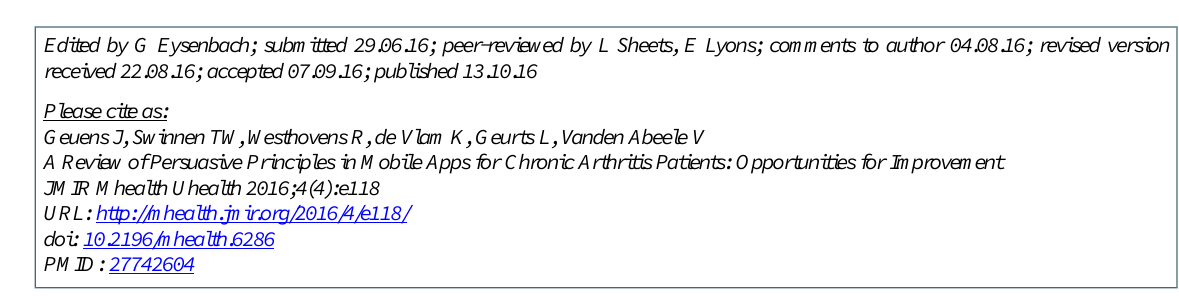
Fogg B, Hreha J. Behavior wizard: a method for matching target behaviors with solutions. In: PERSUASIVE 10.: Springer; 2010 Presented at: 5th International Conference on Persuasive Technology; June 7-10, 2010; Denmark p. 117-131 URL: http://link.springer.com/chapter/10.1007/978-3-642-13226-1_13 [doi: 10.1007/978-3-642-13226-1_13] Abbreviations BCT: behavior change technique CA: chronic arthritis DAS: Disease Activity Score OA: osteoarthritis PSD: Persuasive Systems Design RA: rheumatoid arthritis SpA: